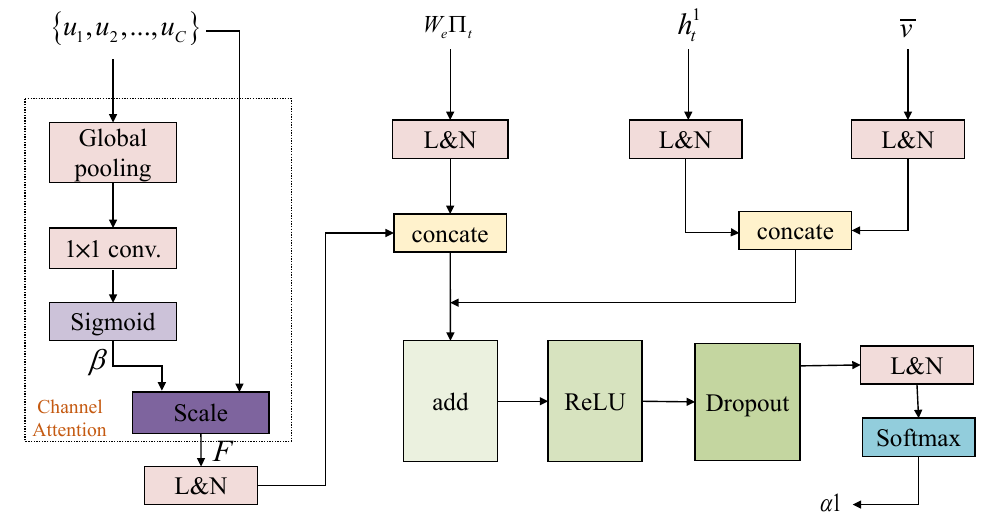
Figure 1. The structure of MSIAM. The L&N layer performs the functions of Linearization and Normalization. The Scale layer weights the input